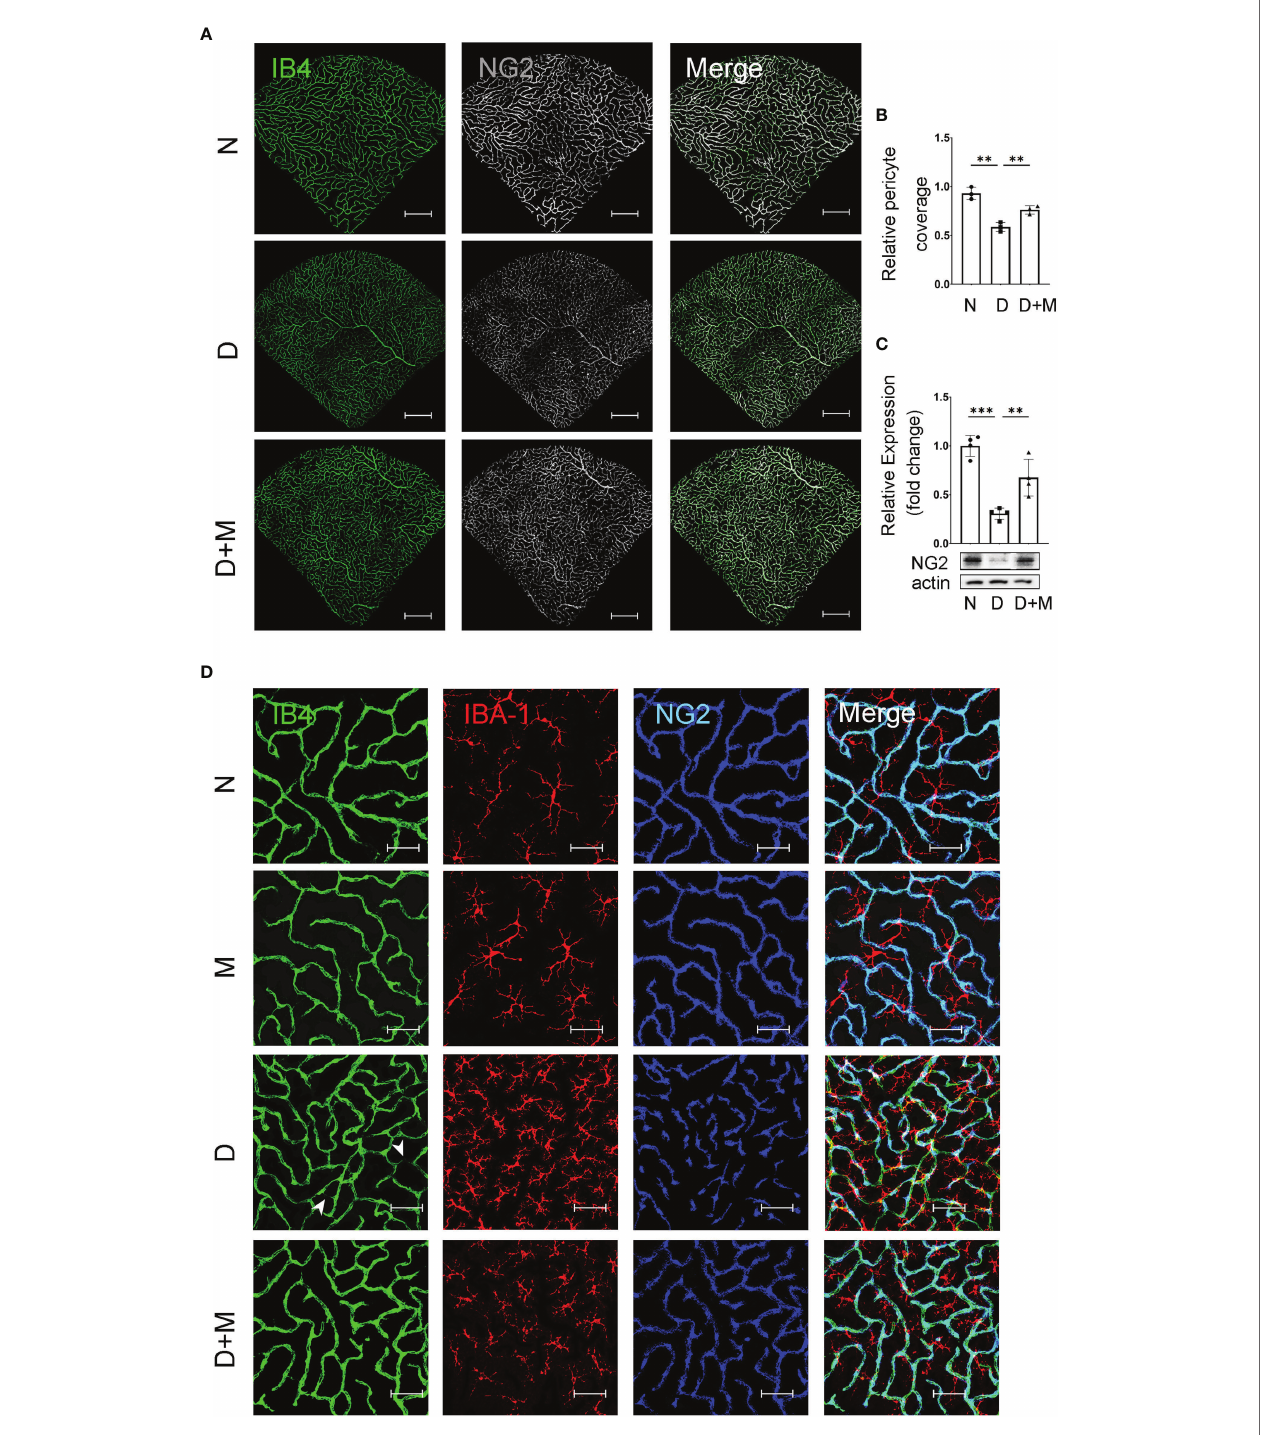
FIGURE 4 | Melatonin prevents retinal pericyte loss in diabetes retinopathy. (A) Representative images of IB4 (green) and NG2 (gray) immunolabeling in normal control and diabetic rat retinas with or without melatonin treatment. (B) Quanti fi cation of pericyte coverage. (C) NG2 expression in normal control and diabetic rat retinas with or without melatonin treatment (n = 4 retinas per group). (D) Representative images of IB4 (green), IBA-1 (red), and NG2 (blue) immunolabeling in normal control and 8-week diabetic rat retinas with or without melatonin treatment. Endothelial loss is indicated by white arrowheads. Data are expressed as mean ± SEM (n = 3 retinas per group). N, normal control group; M, melatonin treatment group; D, diabetes group; D+M, diabetes with melatonin treatment group; **p < 0.01, ***p < 0.001 by one-way ANOVA. Scale bar, 50 m